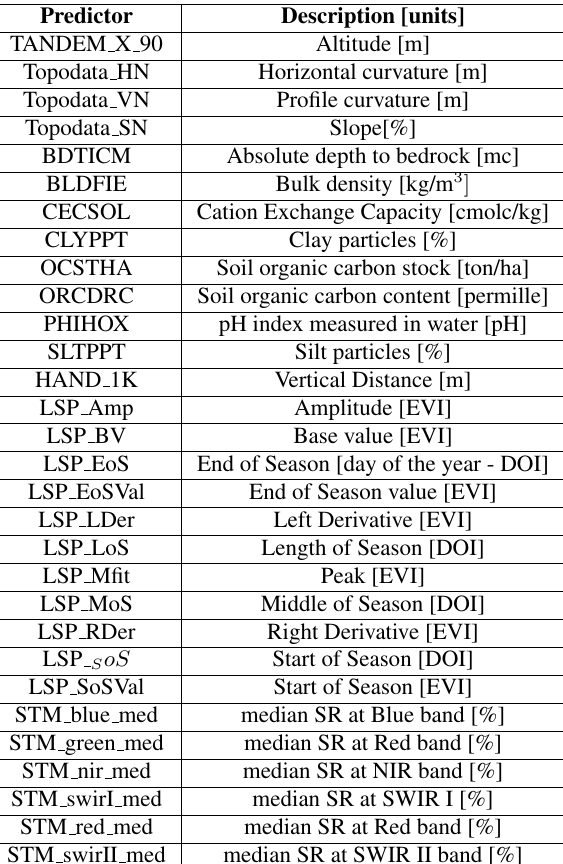
Figure 2. Confusion matrix for the classification model of